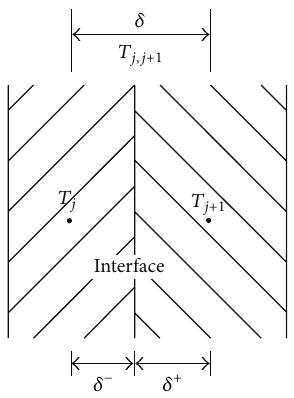
Figure 3: Numerical treatment of coefficient 𝑎 at interface.